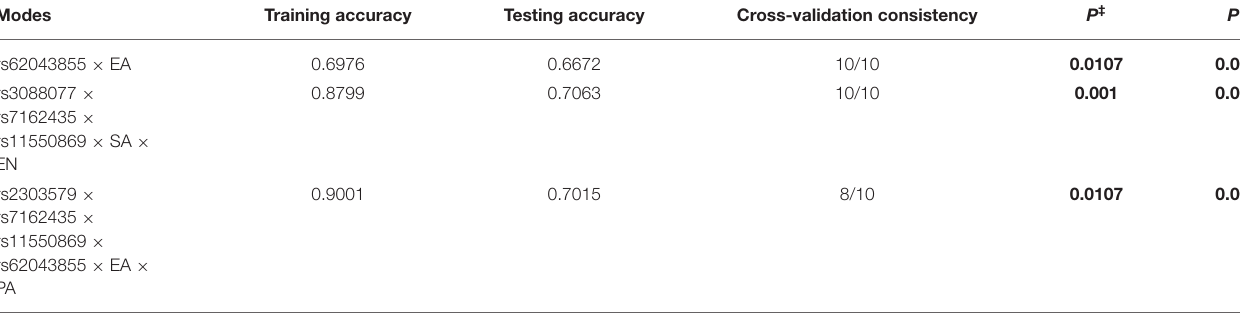
TABLE 7 | GMDR analyses on NEDD4 -CTQ interactions on clinical symptoms in schizophrenia patients grouped by FH.